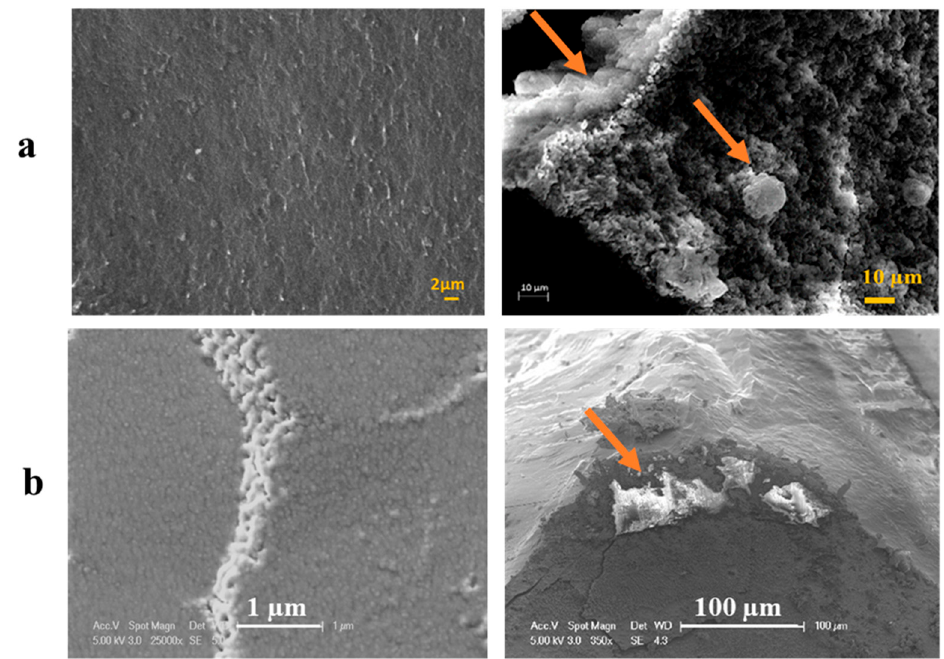
Figure 7. ( a ) SEM micrographs of C 2 G hydrogels without cells and with cells at 168 h after encapsulation. ( b ) Cryo-SEM image of TC 2 G showing the non-porous structure of the hydrogel and osteoblasts inside TC 2 G at 168 h (Scale bar = 100 µ m). The arrows indicate cells in the hydrogel.